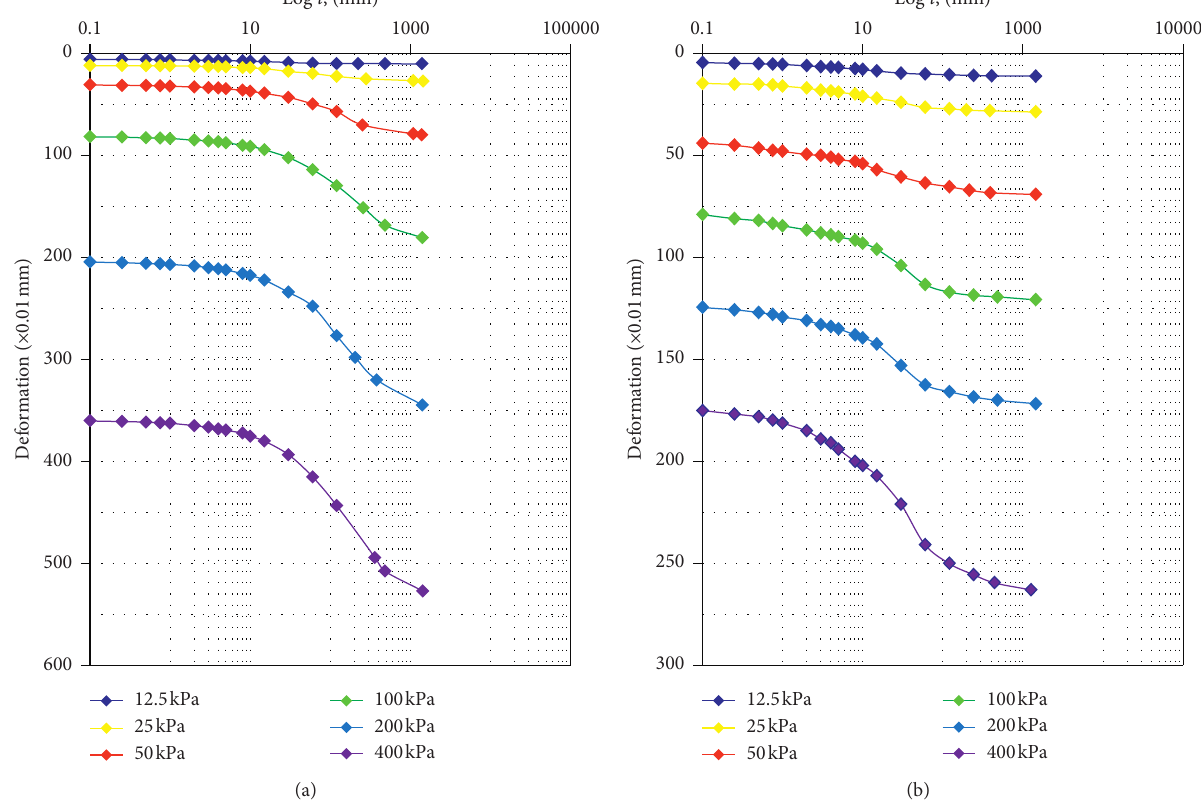
Figure 5: Relationship of deformation and time. (a) Clay soil sample (depth: 2 m—Site 2). (b) Sandy clay sample (depth: 6m—Site